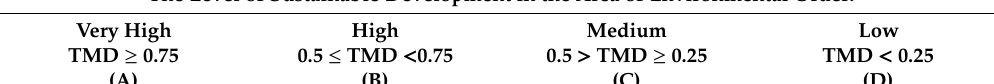
Table 5. Comparison of the level of sustainable development of Polish provinces according to the taxonomic measure in the area of environmental order (2018). The Level of Sustainable Development in the Area of Environmental Order: Very High TMD ≥ 0.75